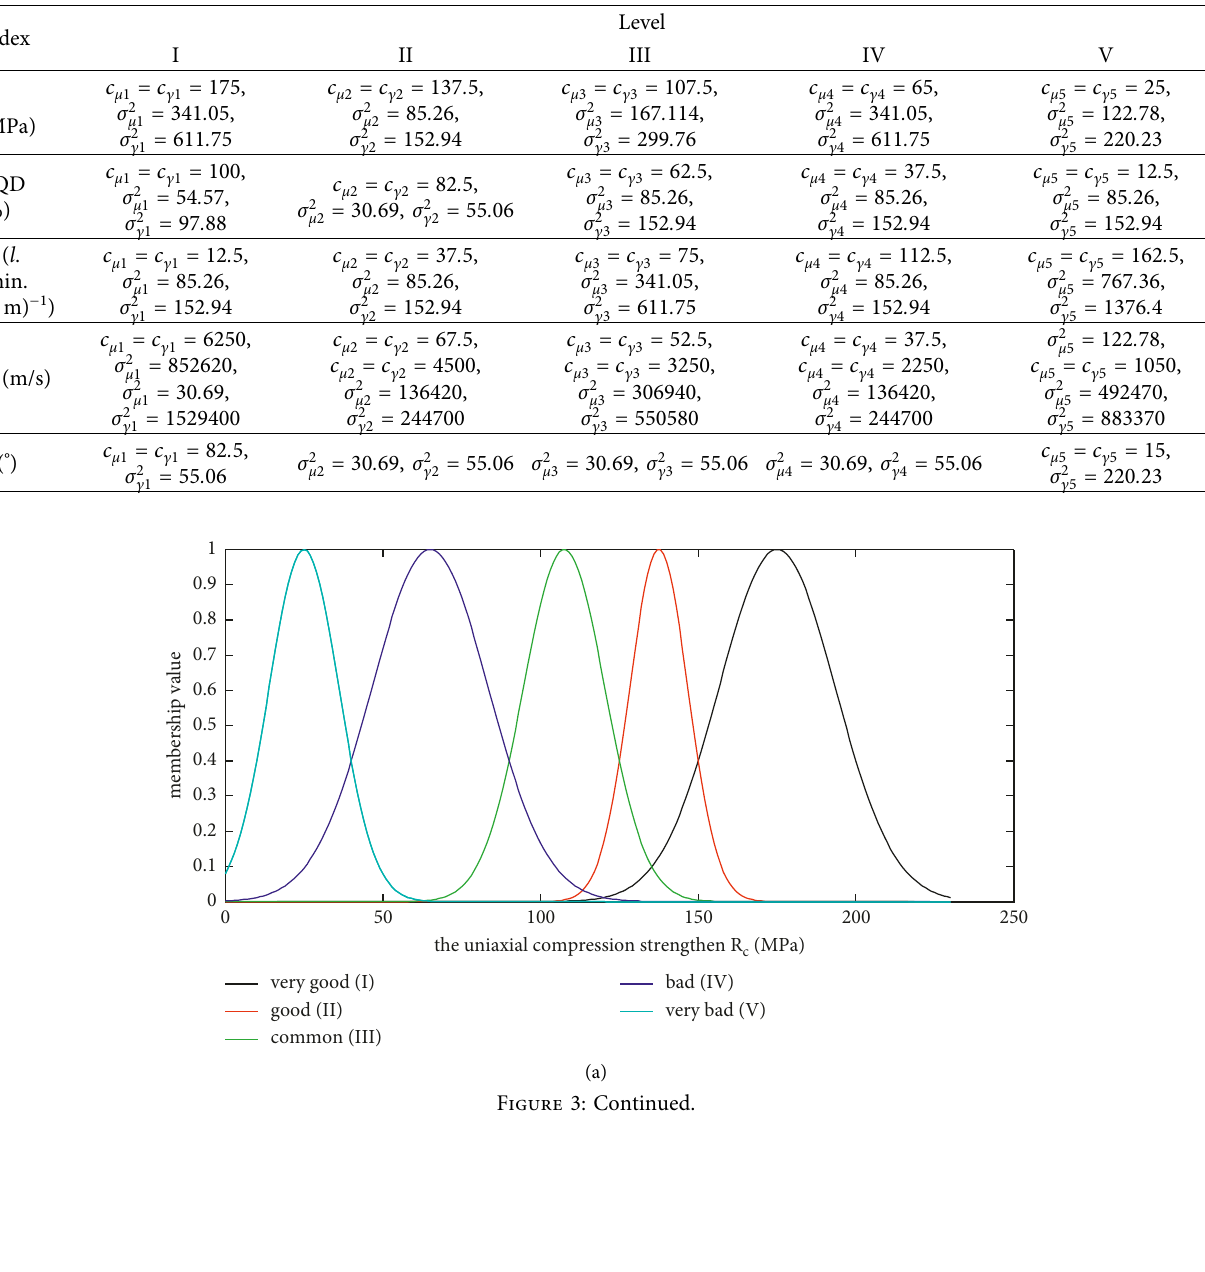
Table 4: The parameters of membership and non-membership degree